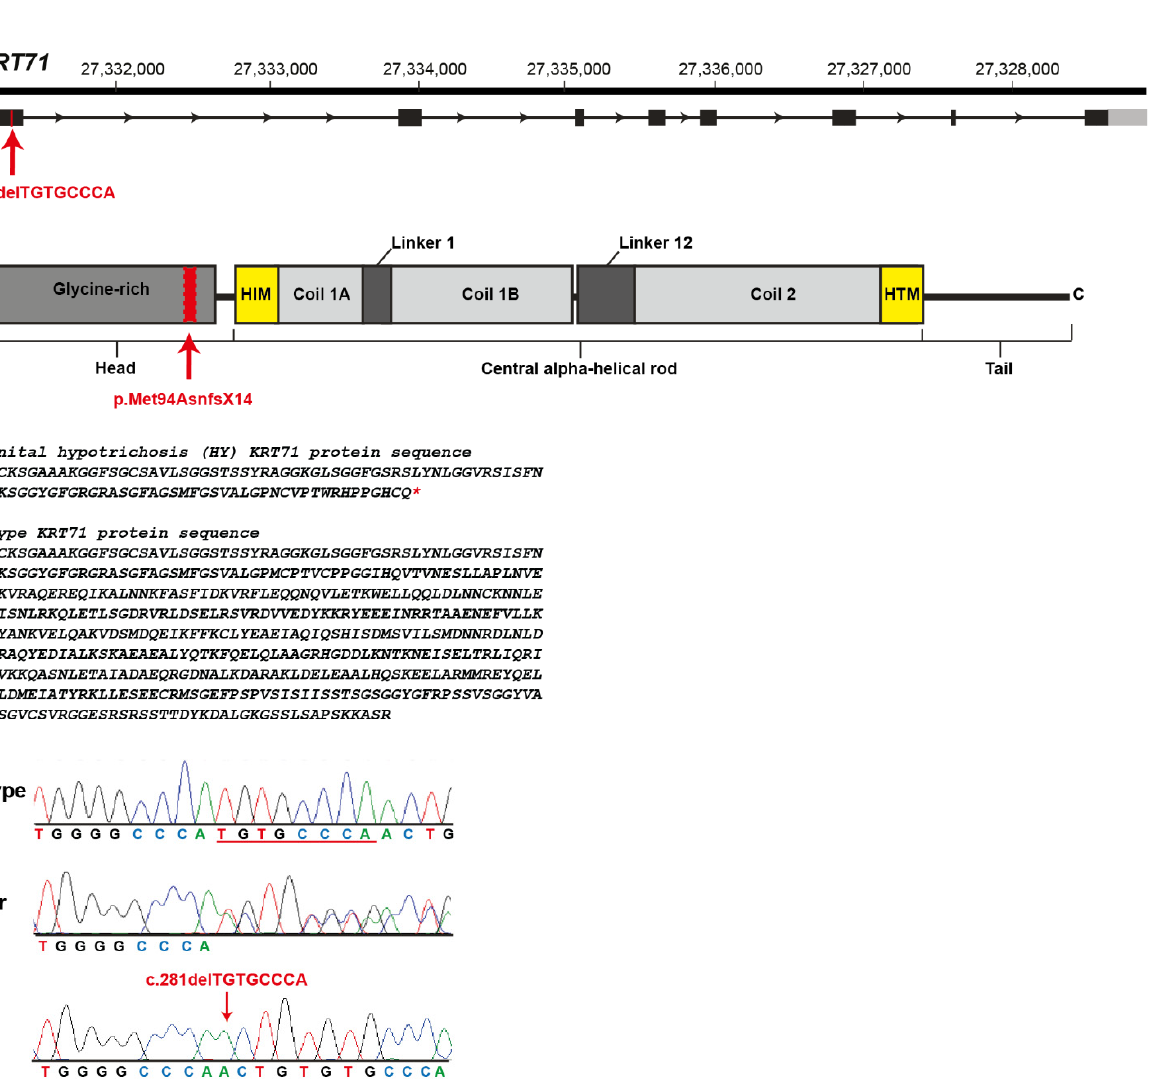
Figure 4. KRT71 deletion in Hereford cattle affected by congenital hypotrichosis. ( a ) KRT71 gene structure showing the location of the exon 1 variant on cattle chromosome 5. ( b ) Schematic representation of KRT71 protein with its three functional domains. ( c ) Predicted protein sequences of an HY and wildtype KRT71 protein. The red star (*) represents a stop codon. The normal protein is 525 amino acid residues in length. The HY protein is expected to be 108 amino acid residues in length due to the premature induction of a stop codon. ( d ) Electropherograms showing the different genotypes identified via Sanger sequencing.